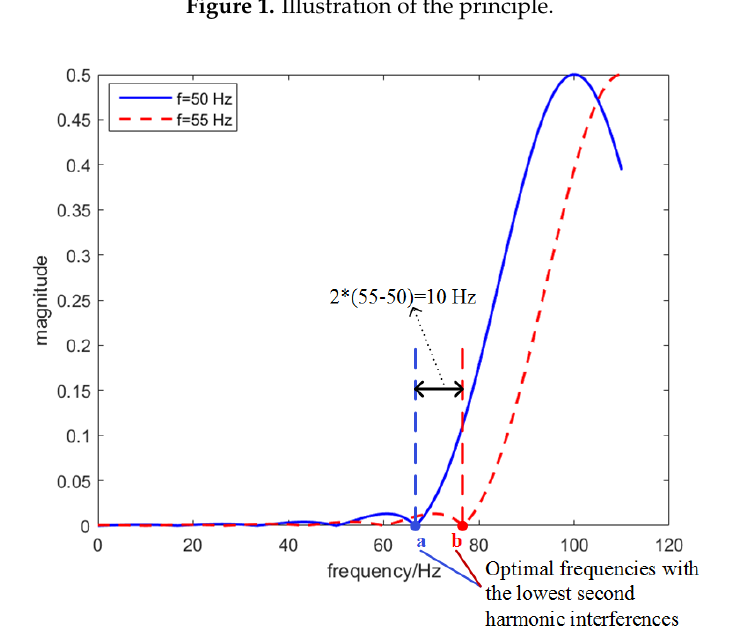
Figure 1. Illustration of the principle.